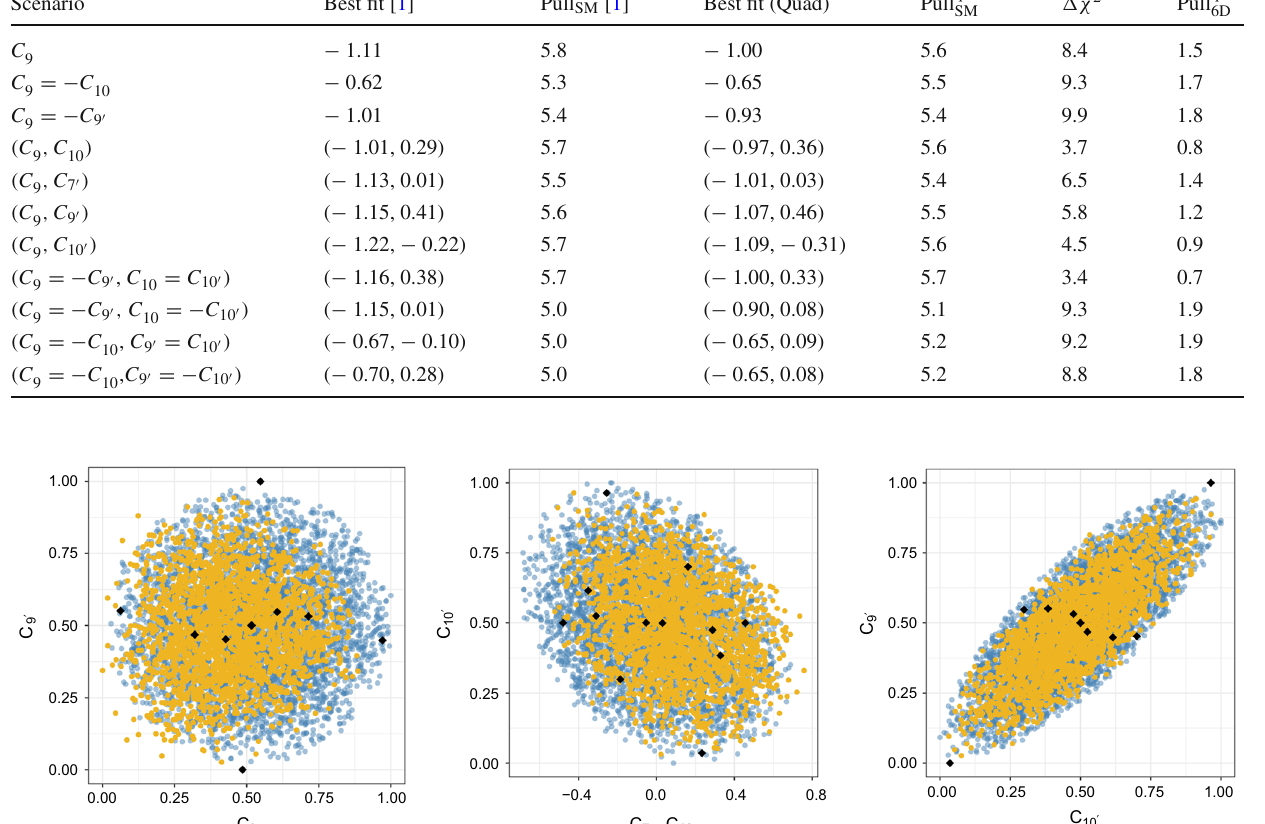
Ref. [1]. The listed Pull indicates that all these scenarios are better than the SM by at least 5 σ and that most of them are between 1 σ and 2 σ